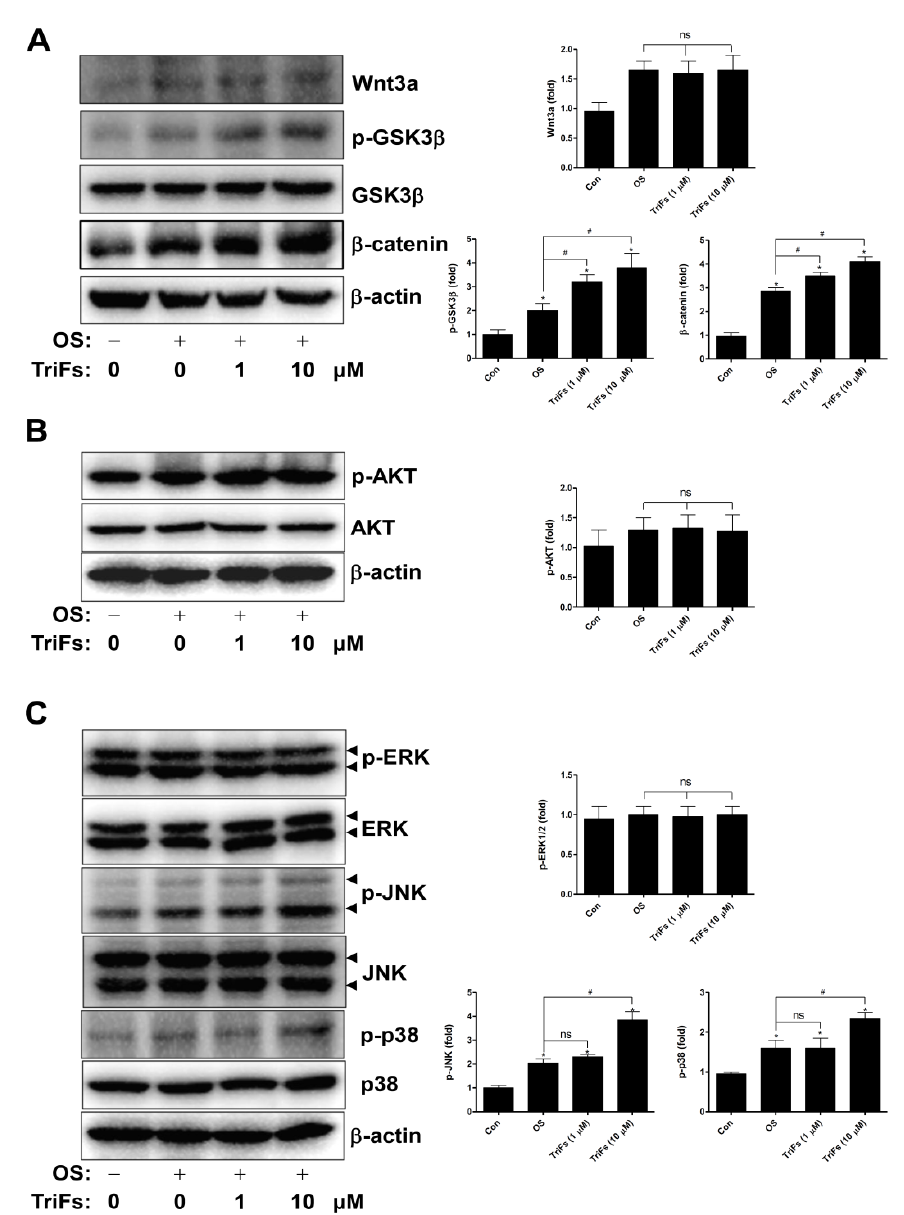
Figure 4. Osteogenic effects of trifloroside (TriFs) on Wnt3a molecules, AKT, and MAPKs. ( A ) Wnt3a, p-GSK3 β , and β -catenin were all probed in equal amounts using Western blotting. Data obtained for the lysates were standardized using β -actin on the same sample. ( B , C ) AKT, p-AKT ( B ), p-ERK, ERK, p-JNK, JNK, p-p38, and p38 ( C ) were all probed in equal amounts using Western blotting. The values (fold) were normalized to β -actin and were displayed as a bar graph. *, p < 0.05 indicates significant differences when compared to the control. #, p < 0.05 indicates significant differences when compared to OS. Data are presented as mean ± standard error of the mean (S.E.M.). ‘ns’, not significant. Data shown are from three independent